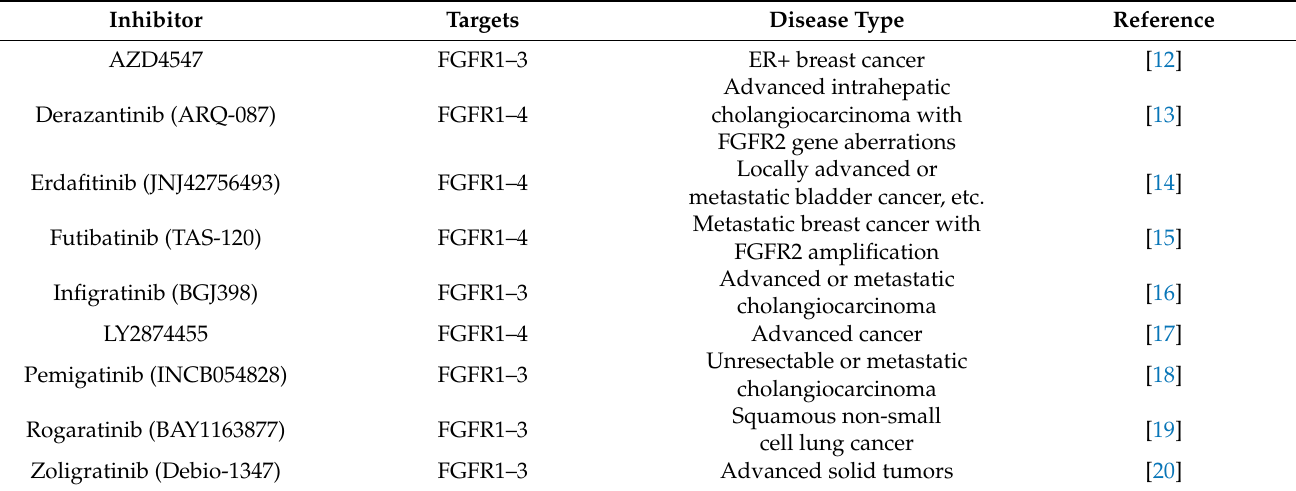
Table 1. Representatives of pan-FGFR inhibitors that target